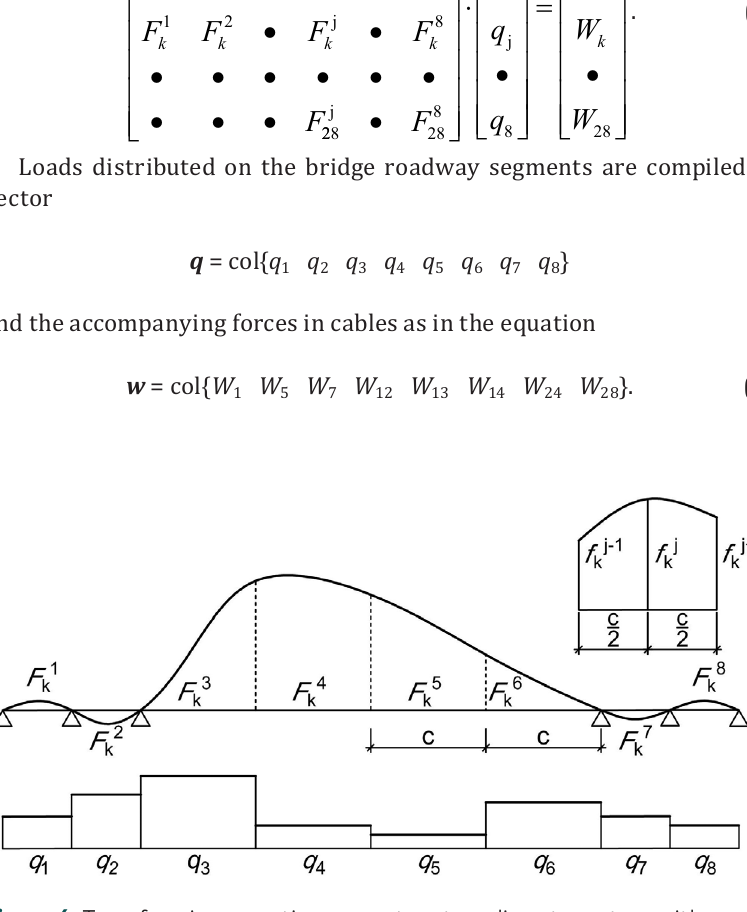
Figure 6. Transforming a continuous system to a discrete system with segments of constant load q